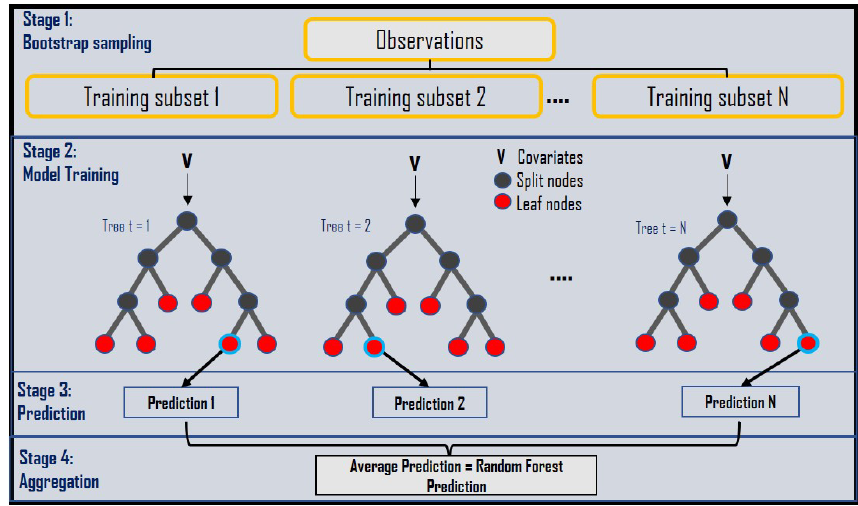
Figure 4. Graphical representation of a standard RF algorithm (adapted from online sources and Fig.